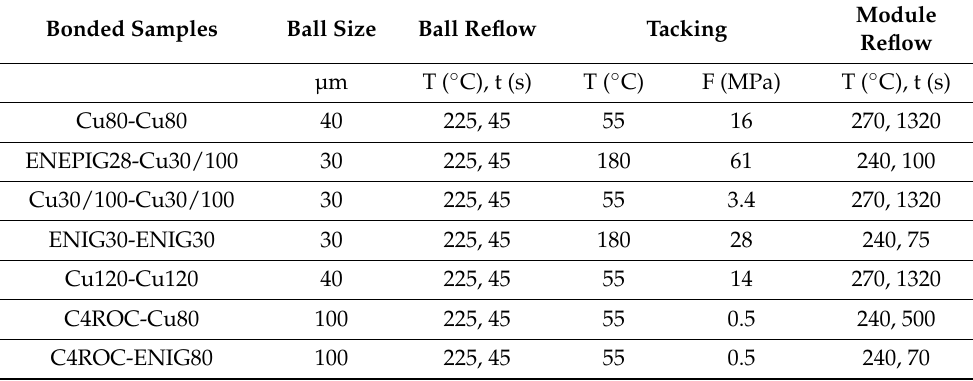
Table 1. Summary of the process parameters, including ball size, peak temperature (T), dwell time (t) and bonding force (F), for all the bonded